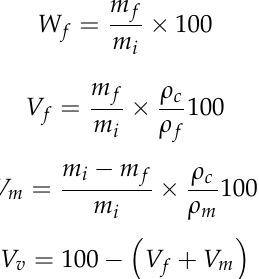
Fiber Weight Fraction (wt%)